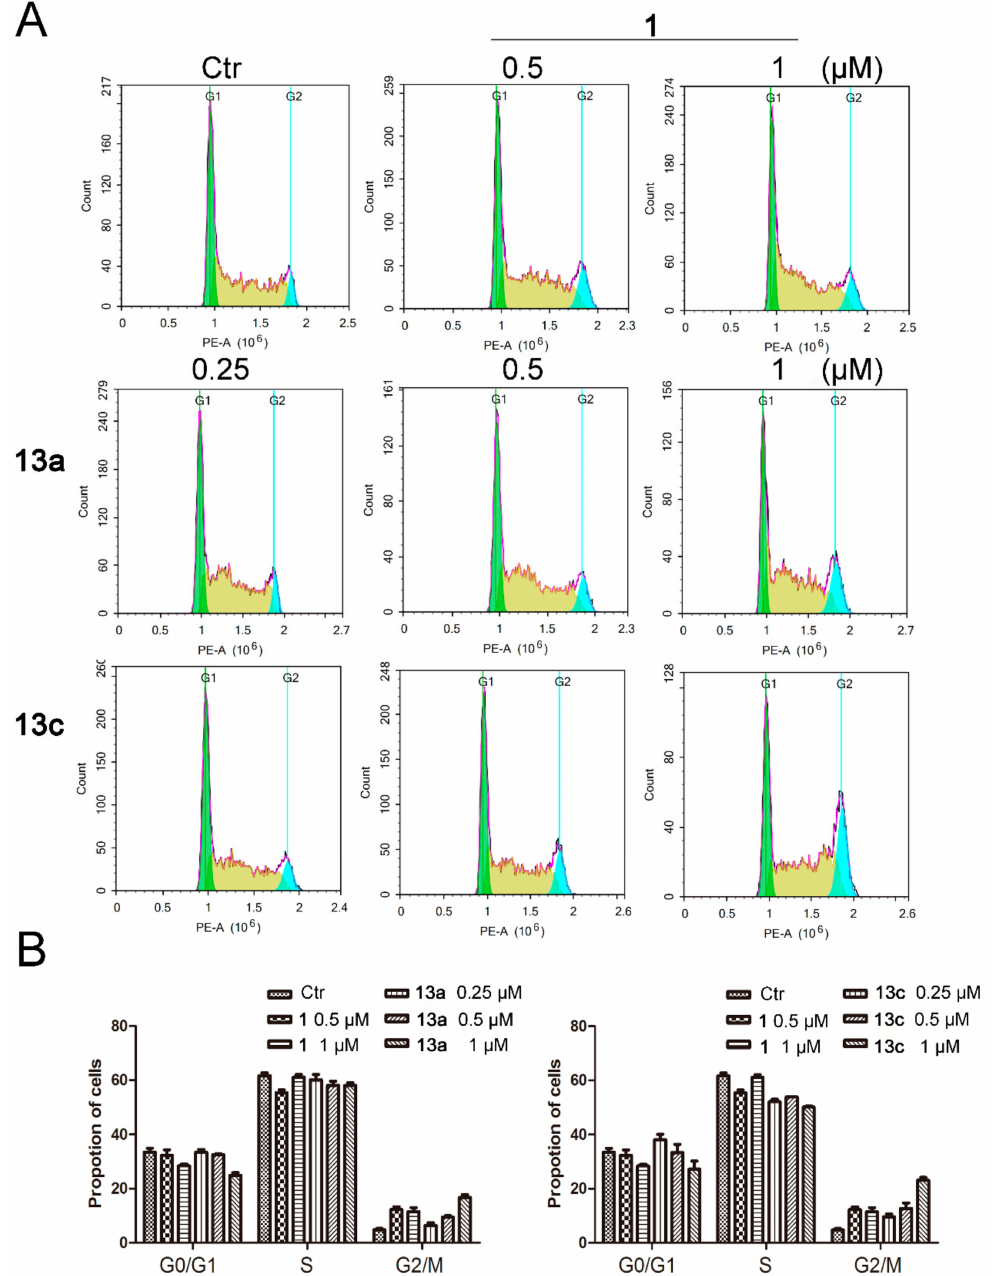
Figure 6. The e ff ects of compounds 13a and 13c on cell cycle progression in MDA-MB-231 cells. ( A ) MDA-MB-231 cells were treated with SAHA or di ff erent doses of 13a and 13c and stained with propidium iodide (PI), followed by flow cytometry analysis. ( B ) Quantitative